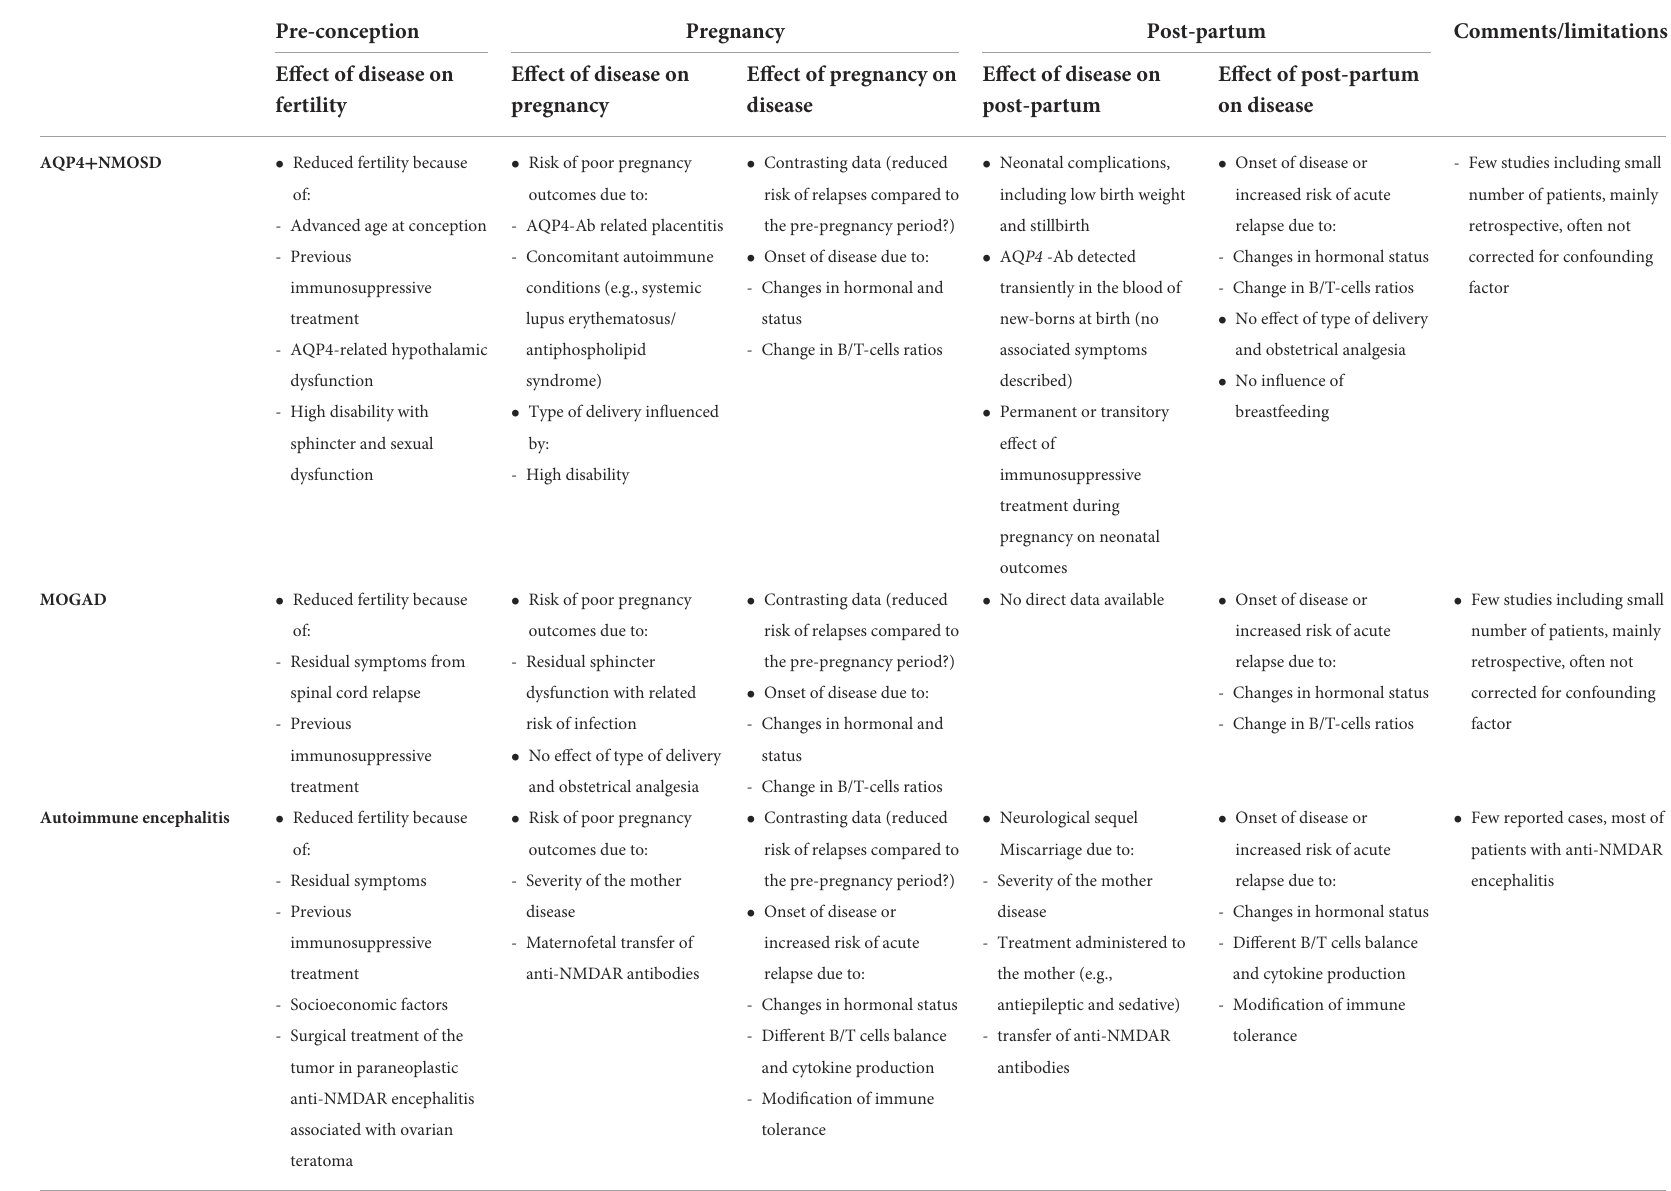
TABLE 2 Impact of each Ab-mediated disease on pregnancy and vice